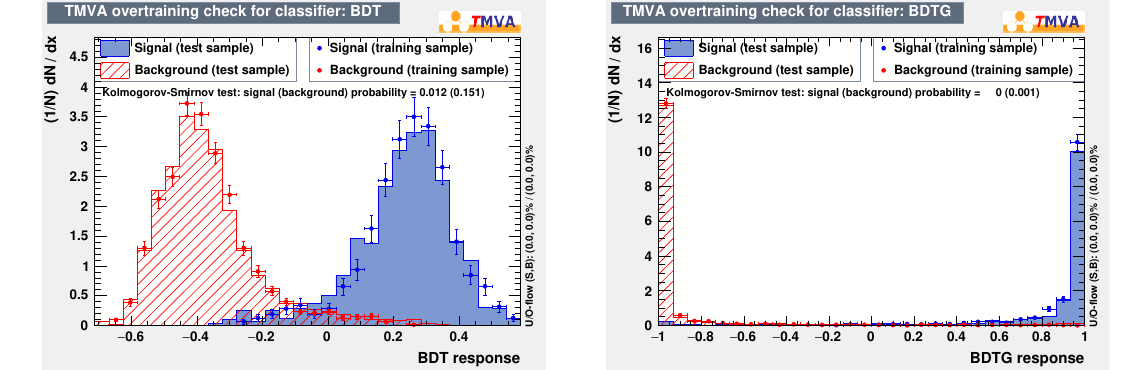
Signal (test sample) Background (test sample)